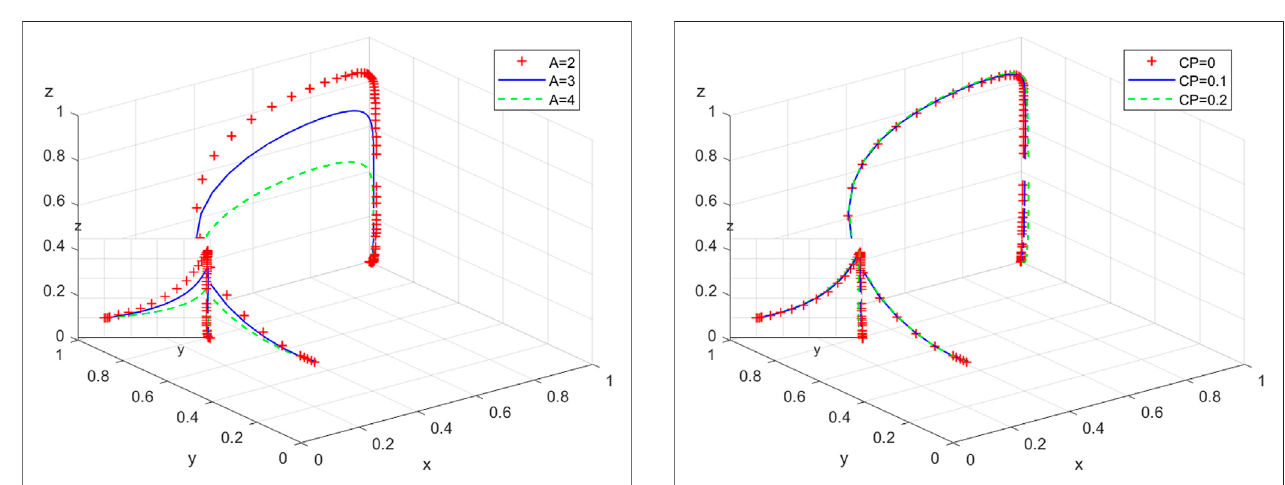
Figure 9 indicates that with the increase of the reward amount set by LGs for the CP, the probability of the CP ’ s participation in marine ecological governance will increase, whereas the probability of the LGs selecting strong regulation will decrease.